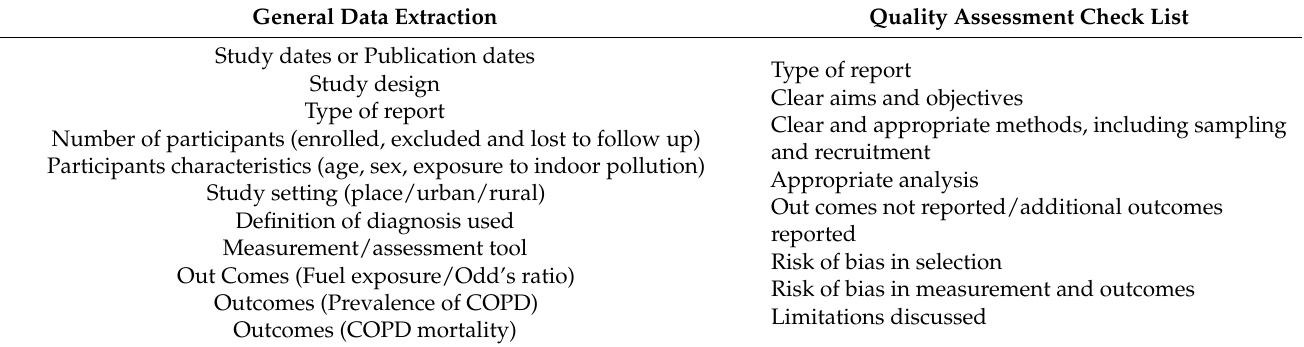
Table 2. Data extraction and quality assessment checklists. The numbers beside the quality assessment criteria are used to indicate the 8 points.